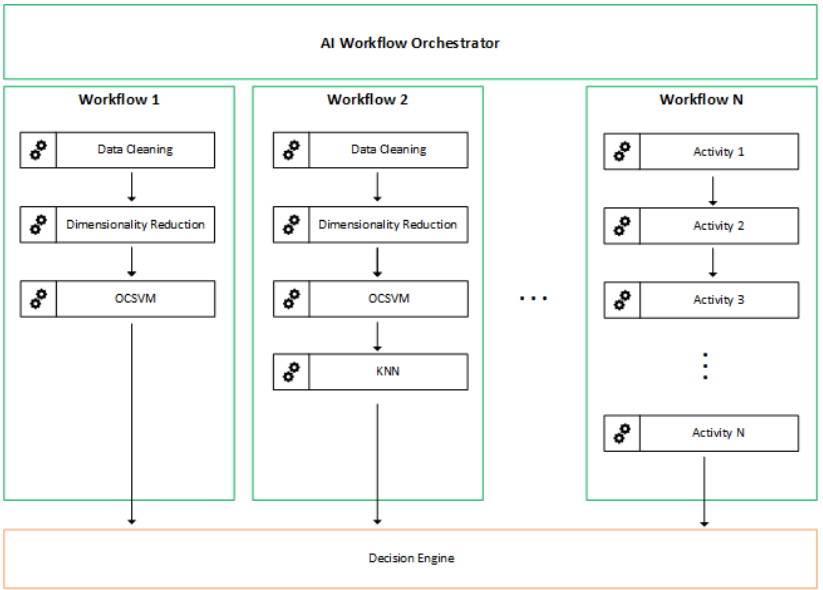
Figure 4. Workflow Orchestrator is responsible for managing several